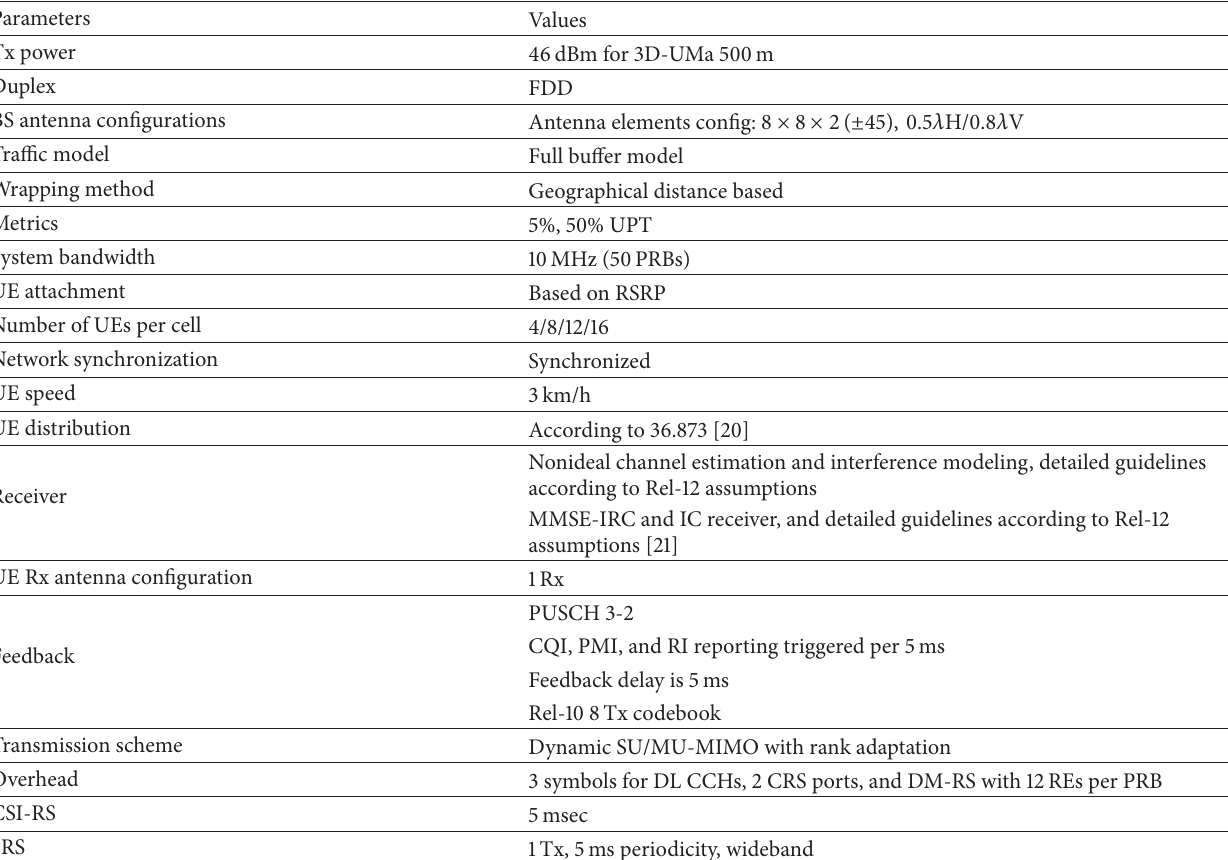
Table 2: Major simulation parameters.